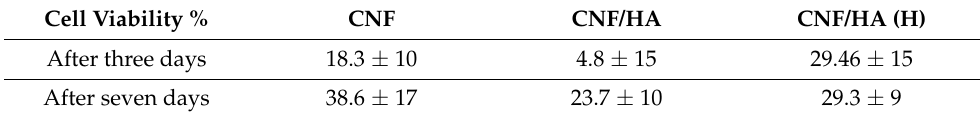
Table 3. Cell viability percentage of the prepared samples after three and seven